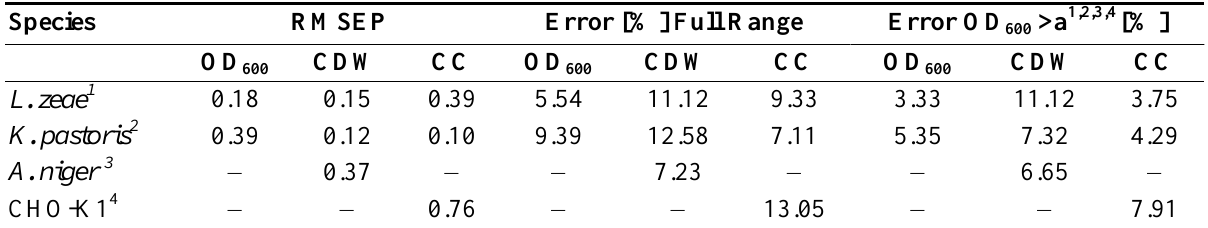
Table 3. Calibration validation results in comparison of two ranges. CDW in g·L −1 , cell